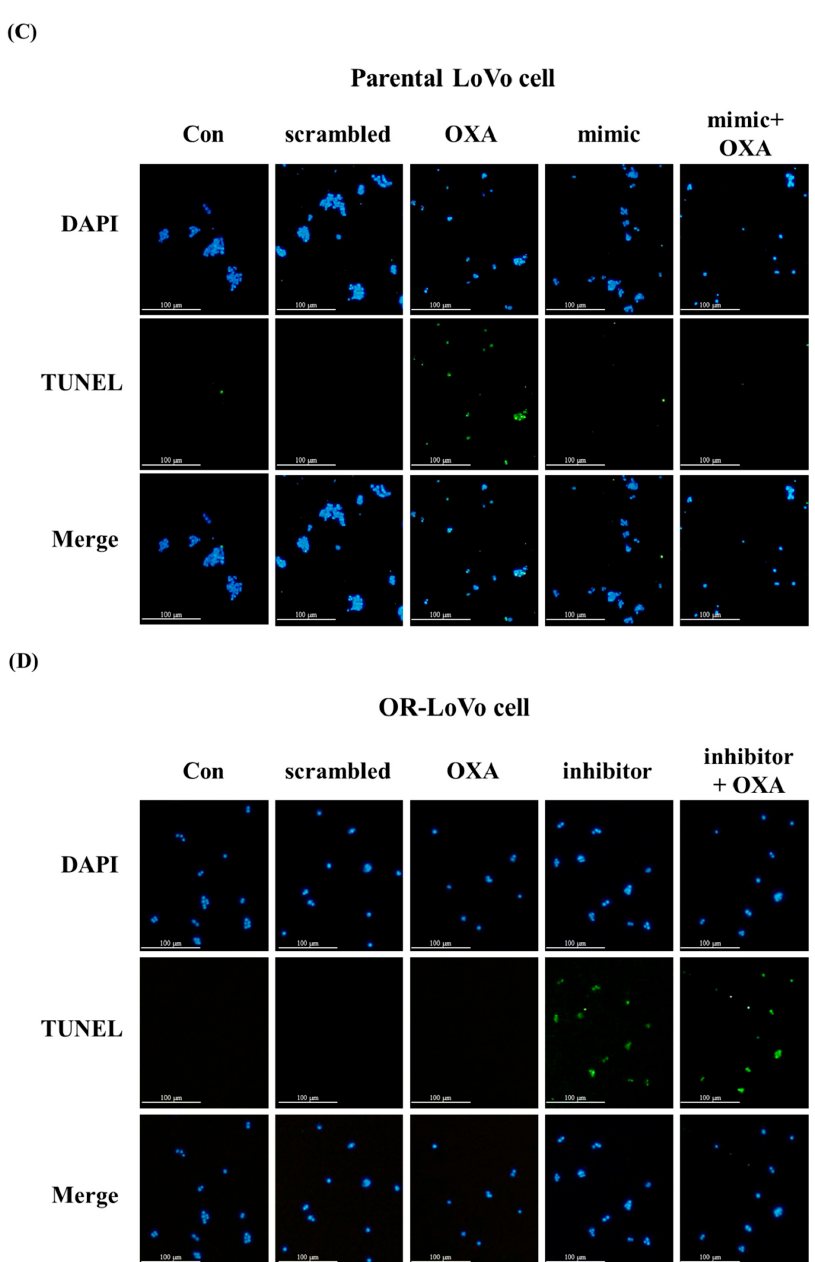
Figure 3. The effect of the overexpression or knockdown of miR-31-5p and treatment with or without OXA on cell survival and cell death of LoVo or OR-LoVo cells in vitro. ( A ) MiR-31-5p expression in LoVo or OR-LoVo cells transfected with a miR-31-5p mimic (40 nM), inhibitor (40 nM), or scrambled miRNA (40 nM) (mimic negative control (NC) or inhibitor NC) or treatment with OXA (45 μ M). MiR-31-5p fold increase which was calculated by the ratio miR-31-5p/U6, being U6 snRNA constitutively expressed. ( B ) Cell survival fold changed of LoVo cells or OR-LoVo cells determined by the MTT assay. The TUNEL assay was used to detect cell death in LoVo cells ( C ) and OR-LoVo cells ( D ). Fluorescein staining was used to indicate apoptotic cells, and DAPI staining was used to determine the number of nuclei and assess the gross cellular morphology. LoVo_scrambled represents the miRNA mimic NC, LoVo_mimic represents the miR-31-5p mimic (overexpression of miR-31-5p), OR_scrambled represents the miRNA inhibitor NC, OR_inhibitor represents the miR-31-5p inhibitor (knockdown of miR-31-5p), and OXA represents oxaliplatin. * p < 0.05 vs. LoVo cells control group; ** p < 0.01 vs. LoVo cells control group; *** p < 0.001 vs. LoVo cells control group. # p < 0.05 vs. OR-LoVo cells control group; ## p < 0.01 vs. OR-LoVo cells control group; ### p < 0.001 vs. OR-LoVo cells control